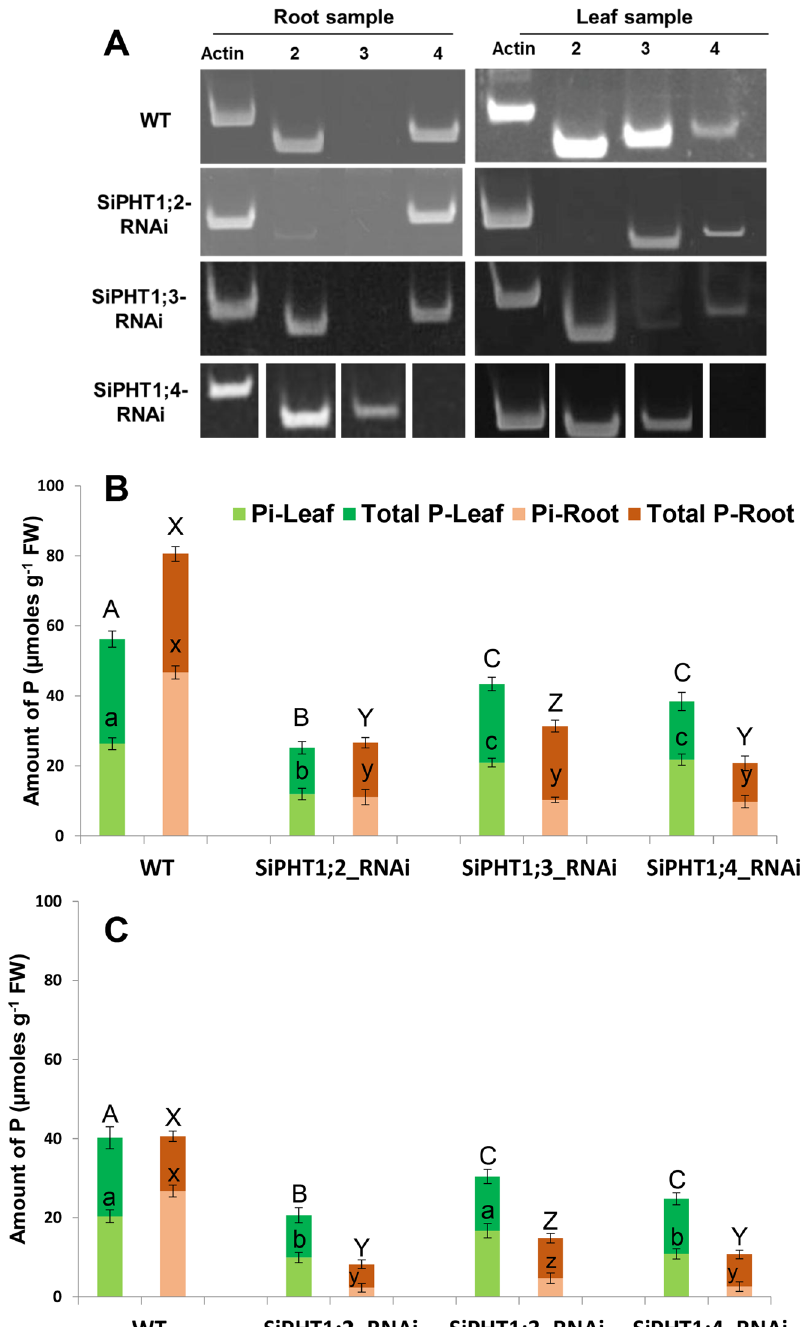
Figure 7. RT-PCR analysis and total and inorganic P content measurement in wild type plants and the 3 RNAi lines. ( A ) RT-PCR analysis of the 3 RNAi lines grown under low phosphorous (10 µ M) using Si-actin , SiPHT1 ; 2 , SiPHT1 ; 3 and SiPHT1 ; 4 gene specific primers. WT = wild type plant (untransformed), SiPHT1 ; 2- RNAi = transgenic plant downregulating SiPHT1 ; 2 , SiPHT1 ; 3-RNAi = transgenic plant downregulating SiPHT1 ; 3 , SiPHT1 ; 4-RNAi = transgenic plant downregulating SiPHT1 ; 4 . Lanes 2, 3 and 4 = amplification with SiPHT1 ; 2 , SiPHT1 ; 3 and SiPHT1 ; 4 gene specific primers respectively. Except SiPHT1 ; 4-RNAi line, all the gels were cropped from various gels done at different time points. For SiPHT1 ; 4-RNAi line, the individual lanes were from different gels which are indicated by delineating white lines. The individual gels were captured with different exposure times. T1 seedlings (4 weeks old) of RNAi lines grown under high Pi ( B ) and low Pi ( C ) were analysed for total and Pi contents. The total and Pi content of 2 weeks old (on hydroponics) seedlings were assayed using the same reported protocol 8 . The total height of the bars represents the total P. The lighter shading indicates that proportion of the total P that is Pi and the difference is the organic. Values were expressed as mean ± SD of 3 independent RNAi lines grown under low and high Pi. Values followed by the same letter are not significantly different ( P > 0 . 001